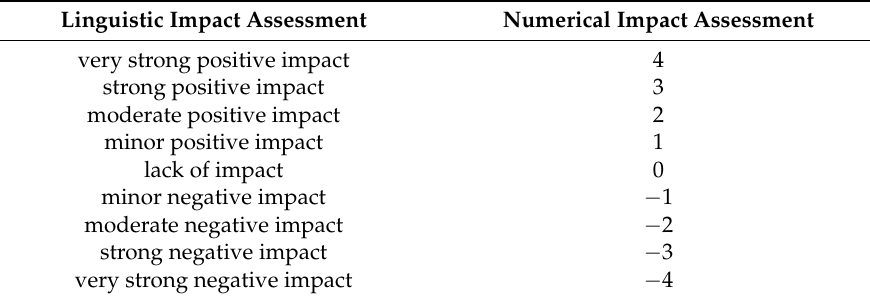
Table 2. The scale of technology impact assessment.